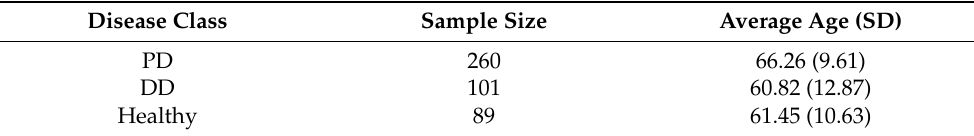
Table 1. Participant population. DD: differential diagnoses including movement disorders other than PD as essential tremor, atypical Parkinsonism, secondary causes of Parkinsonism and dystonia, multiple sclerosis.